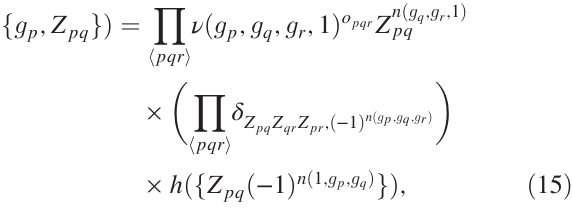
FIG. 4. The vertices around a triangle are ordered by the number of links pointing towards the vertex. o depending on the orientation of the triangle relative to a choice of orientation for the